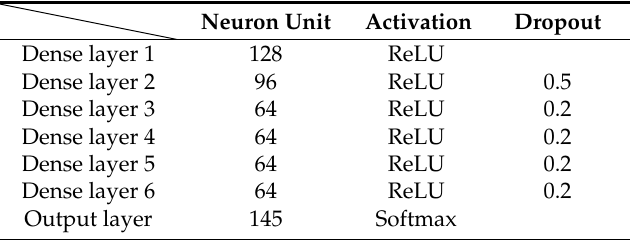
Table 2. Parameters and operations used in dense layers and output layer.